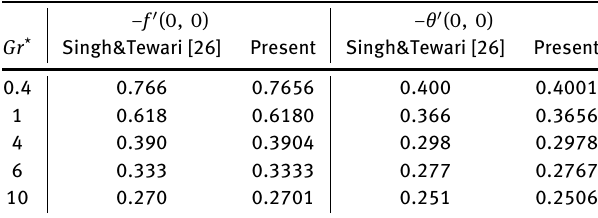
Table 1: Comparison of − f ′ (0, 0) and − θ ′ (0, 0) for various values of